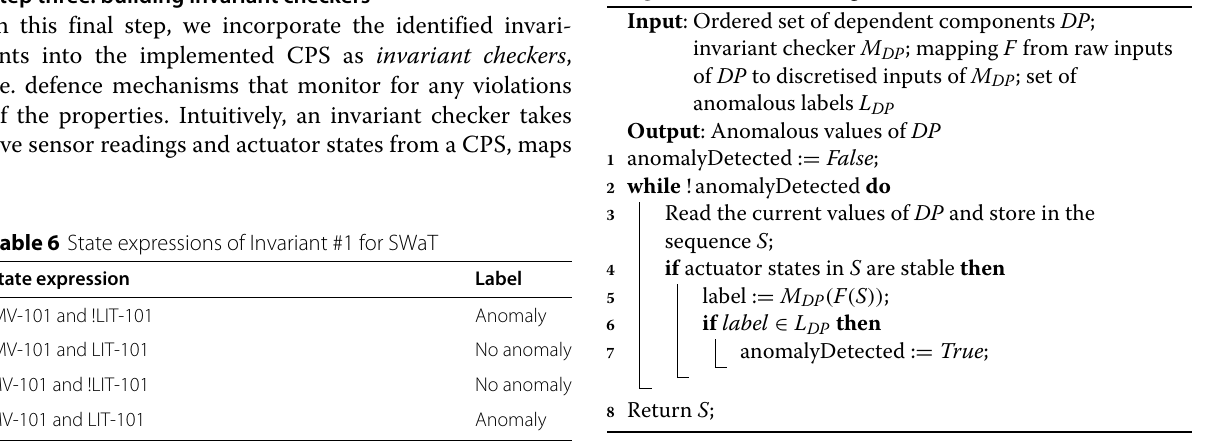
Algorithm 1: Detecting